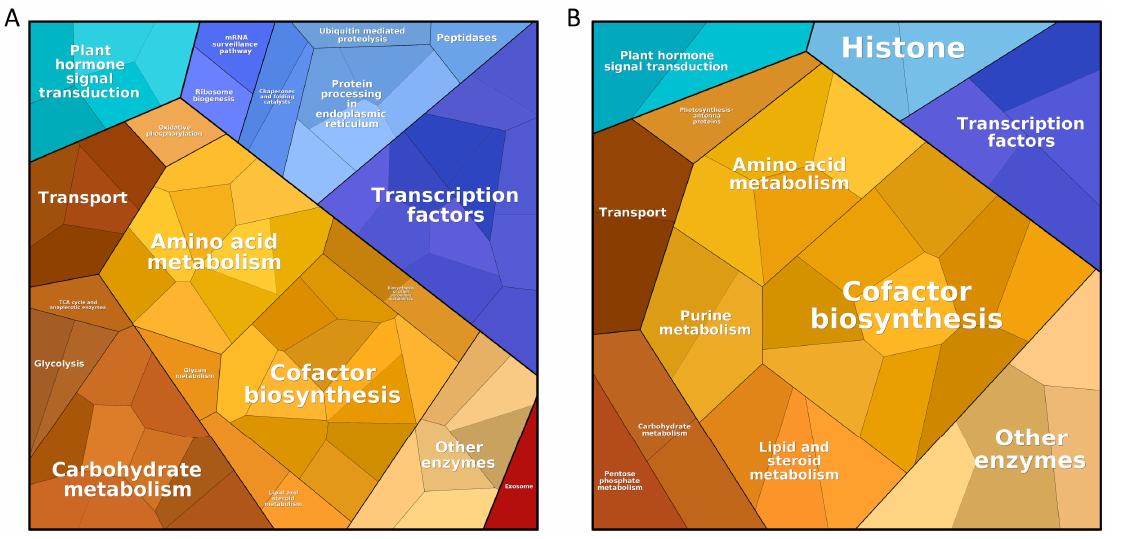
Figure 6. Functional groups of genes with similar stress regulation in at least three abiotic stresses (identified in Figure 4): ( A ) 222 genes upregulated in at least 3 stresses; ( B ) 197 genes downregulated in at least 3 stresses. Visualization was prepared using proteomaps [222].